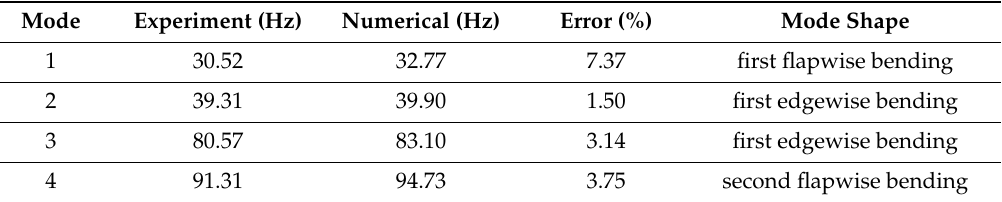
Figure 19. The mode shapes: ( a ) first mode, ( b ) second mode, ( c ) third mode, and ( d ) fourth mode. Table 7. The experimental and numerical modal frequencies.